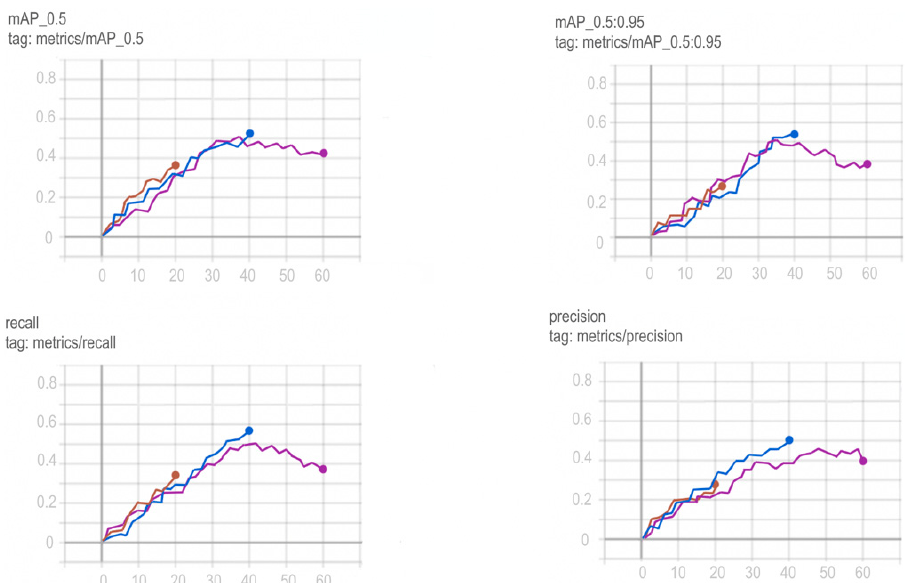
Figure 14. Comparison of training Mask R-CNN at 20 (red graph), 40 (blue graph) and 60 (purple graph) epochs.